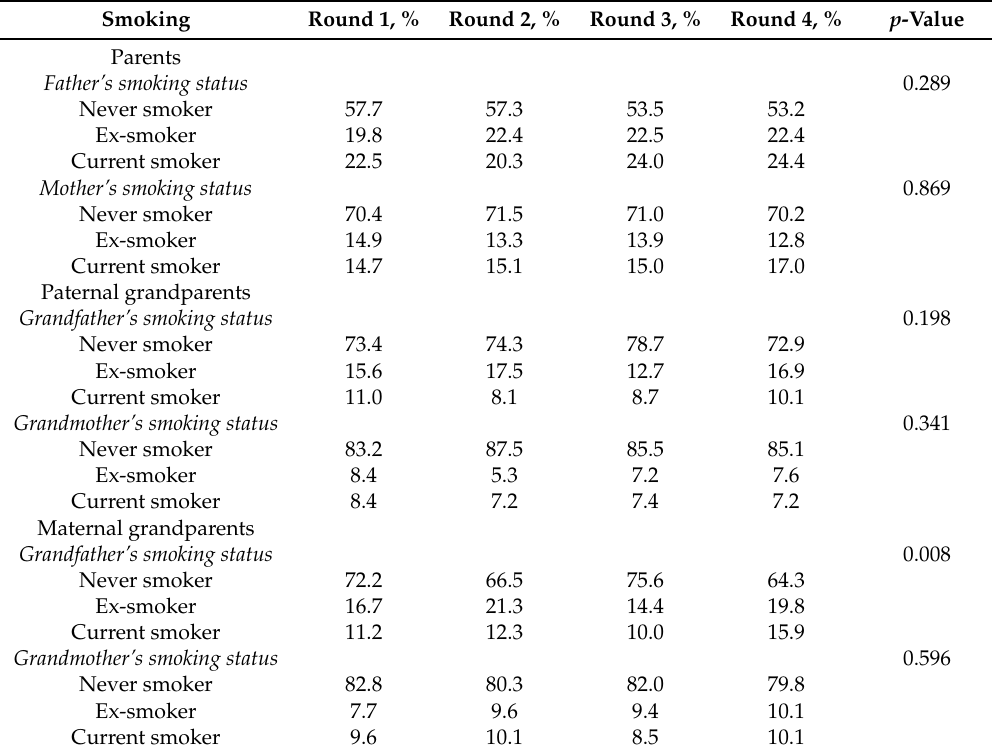
Table A1. Distribution of children’s smoking experimentation, daily smoking and other tobacco product use * and parents’ and grandparents’ smoking by mailing order and the p -value.